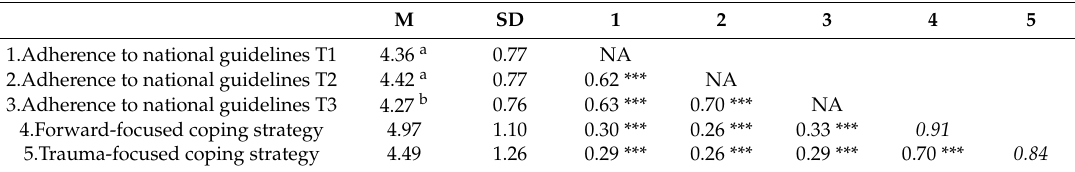
Table 5. Bivariate Correlations among Behavioral